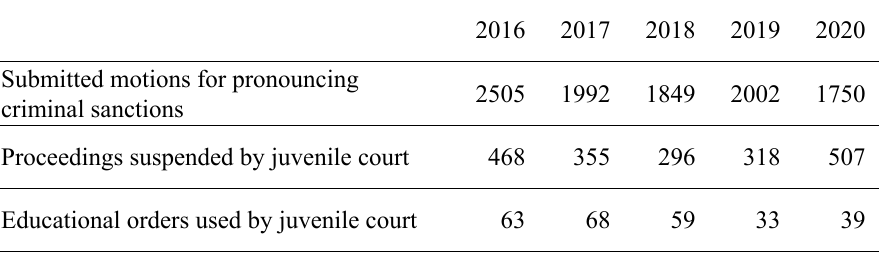
Table 2. Juvenile court statistics in Serbia from 2016 to